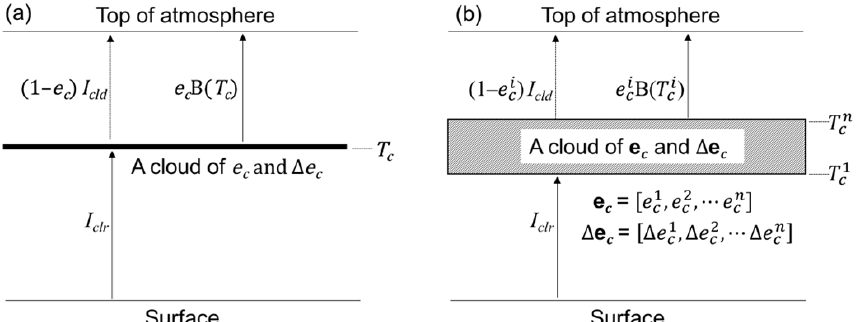
Figure 2. The conceptual model for (a) a plane-parallel homogeneous cloud layer with no scattering, characterized by cloud emissivity ( e c ) and cloud emissivity differences between two infrared channels ( (cid:49)e c ) at the cloud temperature ( T c ) and (b) a number of plane-parallel homogeneous cloud layers (the stripes box) with a possible range of e c and (cid:49)e c such as e c = [ e 1 c e 2 c ...,e n c ] and (cid:49)e c = [ (cid:49)e 1 c (cid:49)e 2 c ...,(cid:49)e n c ] corresponding to a possible range of cloud temperature, T c = [ T 1 c T 2 c ...,T n c ], where I clr and B are the clear-sky radiance and the Planck’s function, respectively. Arrows represent upwelling